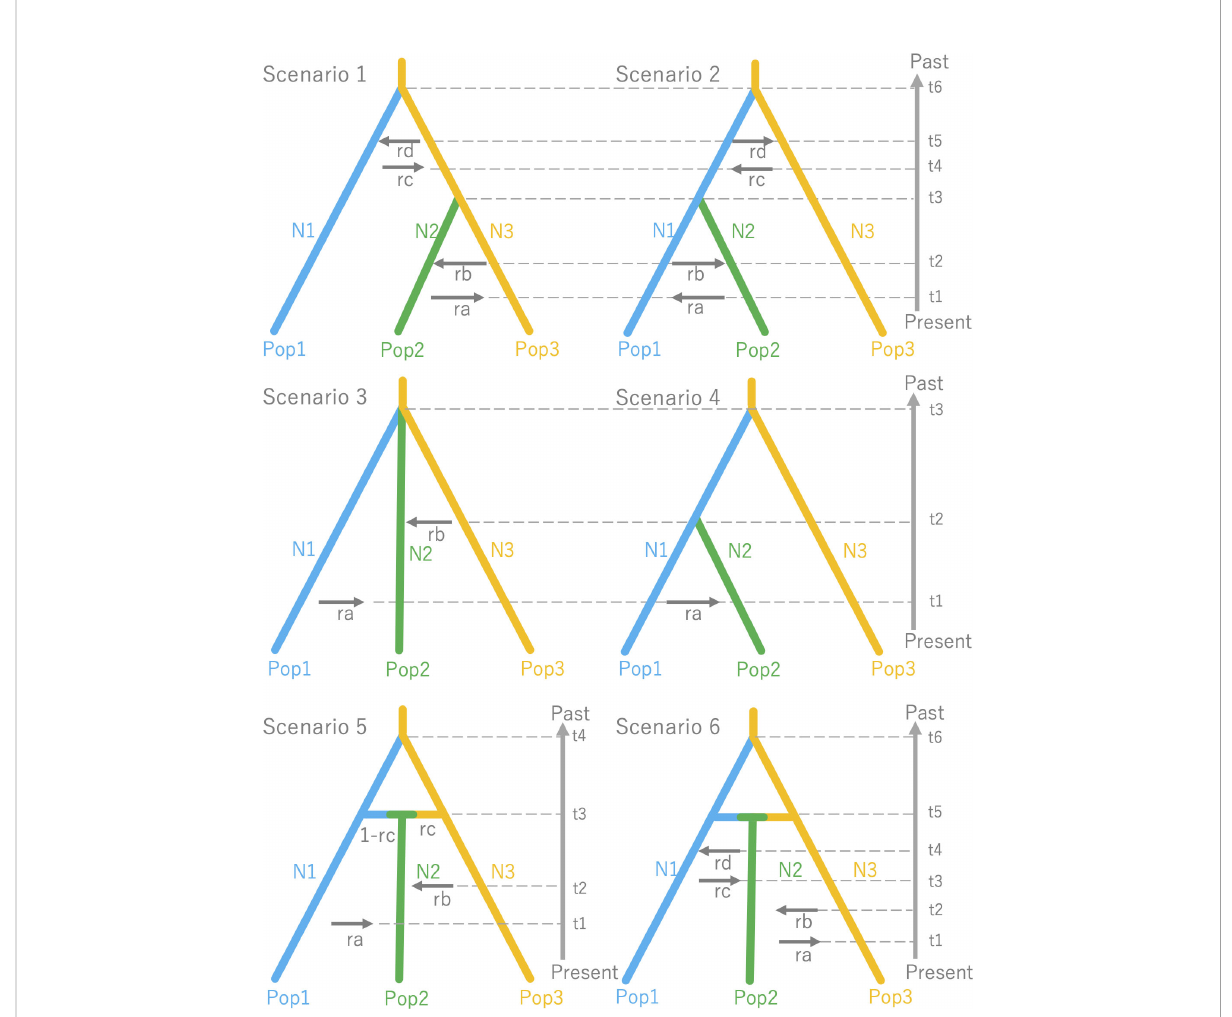
FIGURE 2 Six simple population demography scenarios used for Approximate Bayesian Computation